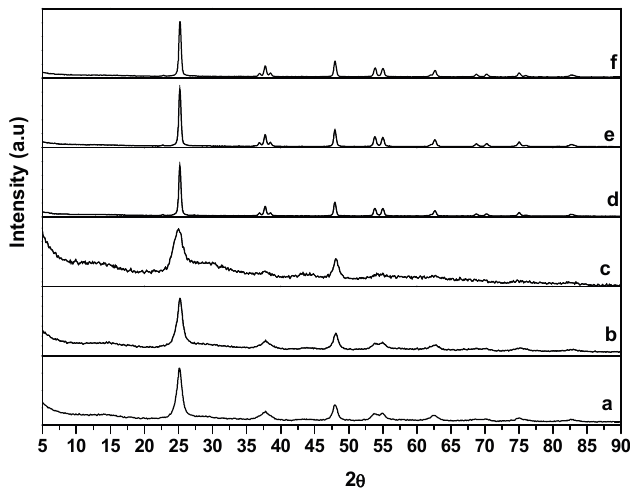
Figure 1. XRD profiles of ( a ) TiNT; ( b ) TiNT-O 2 ; ( c ) TiNT-O 2 -H 2 ; ( d ) cTiNT-; ( e ) cTiNT-O 2 ; ( f ) cTiNT-O 2 -H 2 . Note that traces a – c have been included here for completeness and are reproduced from Figure 2 in reference [12]. Reprinted with permission from: